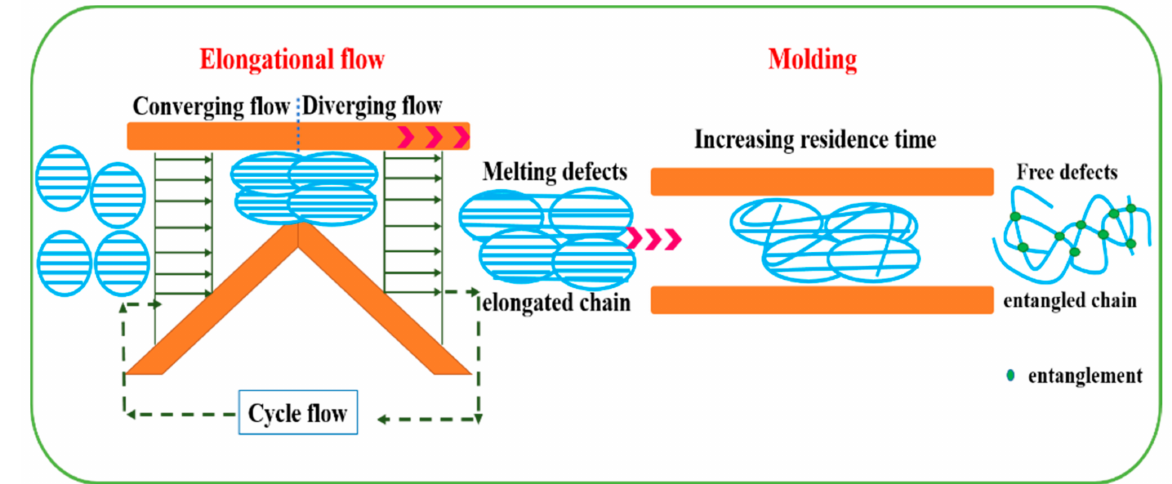
Figure 6. Schematic diagram of UHMWPE-nascent powders under an elongation flow with different residence time [18].